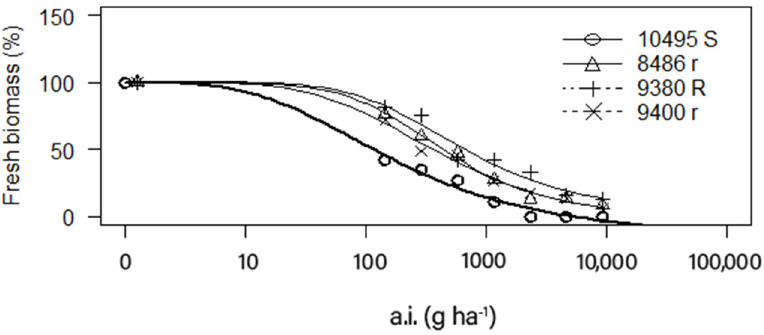
Figure 3. Dose-response curves of Centaurea cyanus population resistant (R), with reduced susceptibility (r) and susceptible (S) to dicamba. bility (r) and susceptible (S) to dicamba.